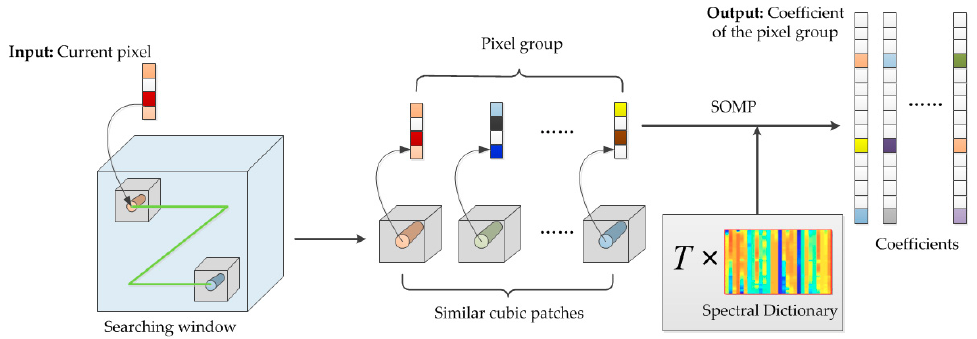
Figure 3. Pixel Group based Non-local Sparse Representation.